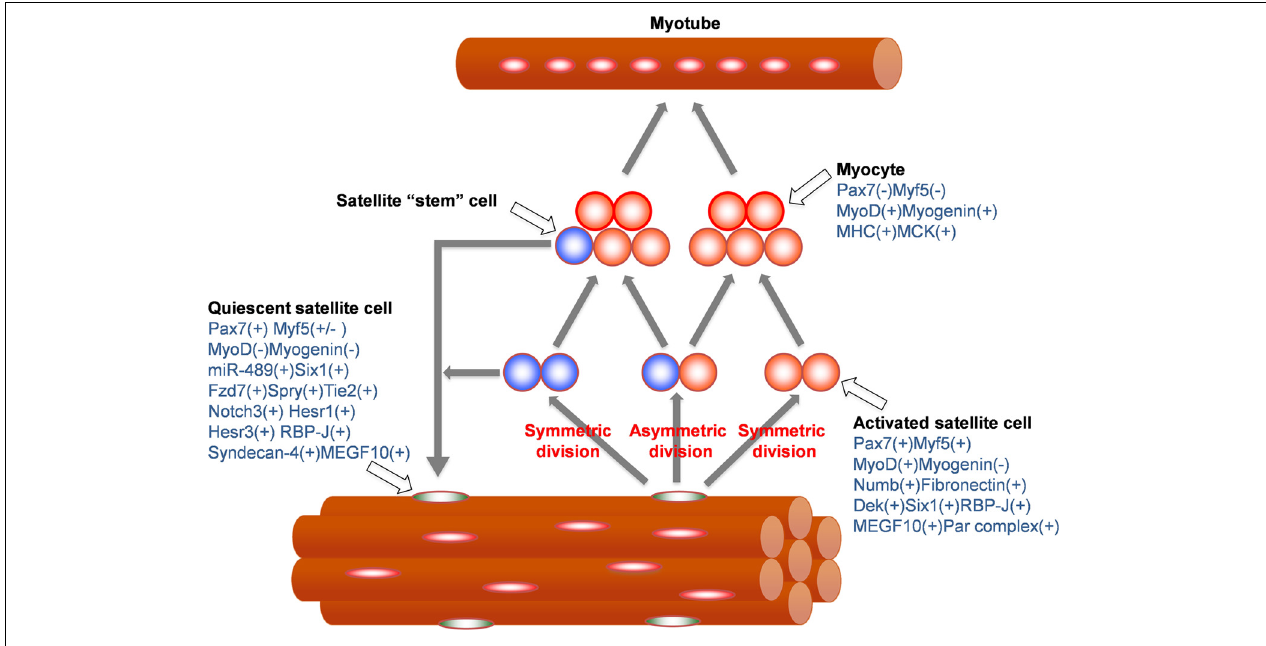
FIGURE 1 | Molecular markers for quiescent satellite cells, activated satellite cells, and myocytes. Quiescent satellite cells are activated by signals from muscle injury and start cell division which include symmetric and asymmetric divisions to produce activated satellite cells and self-renewing